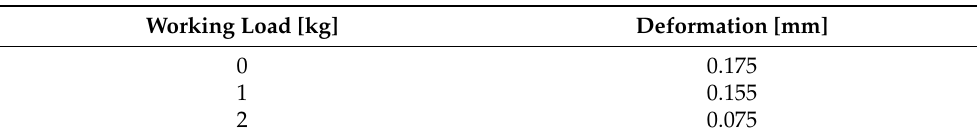
Table 3. Size of deformation in the direction of axis Z for AdM_NcM, determined by the experimental measurement.